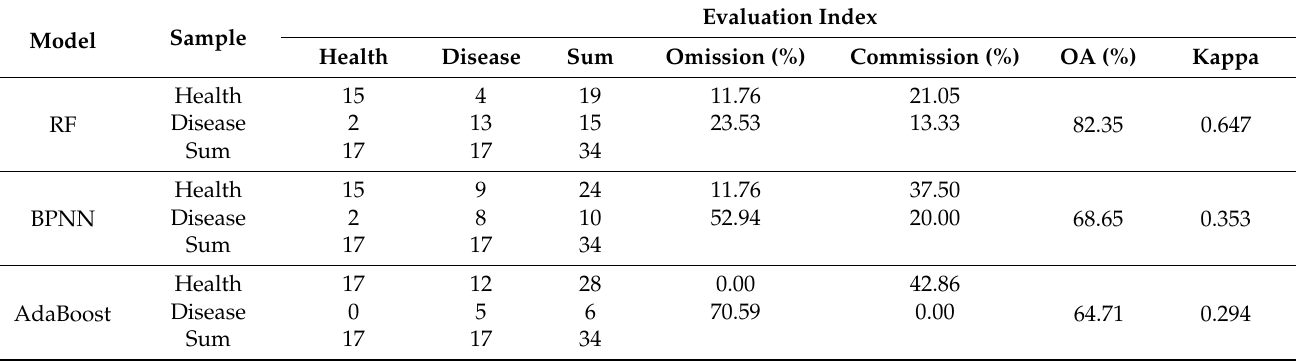
Table 6. Verification results of the three monitoring models based on all feature